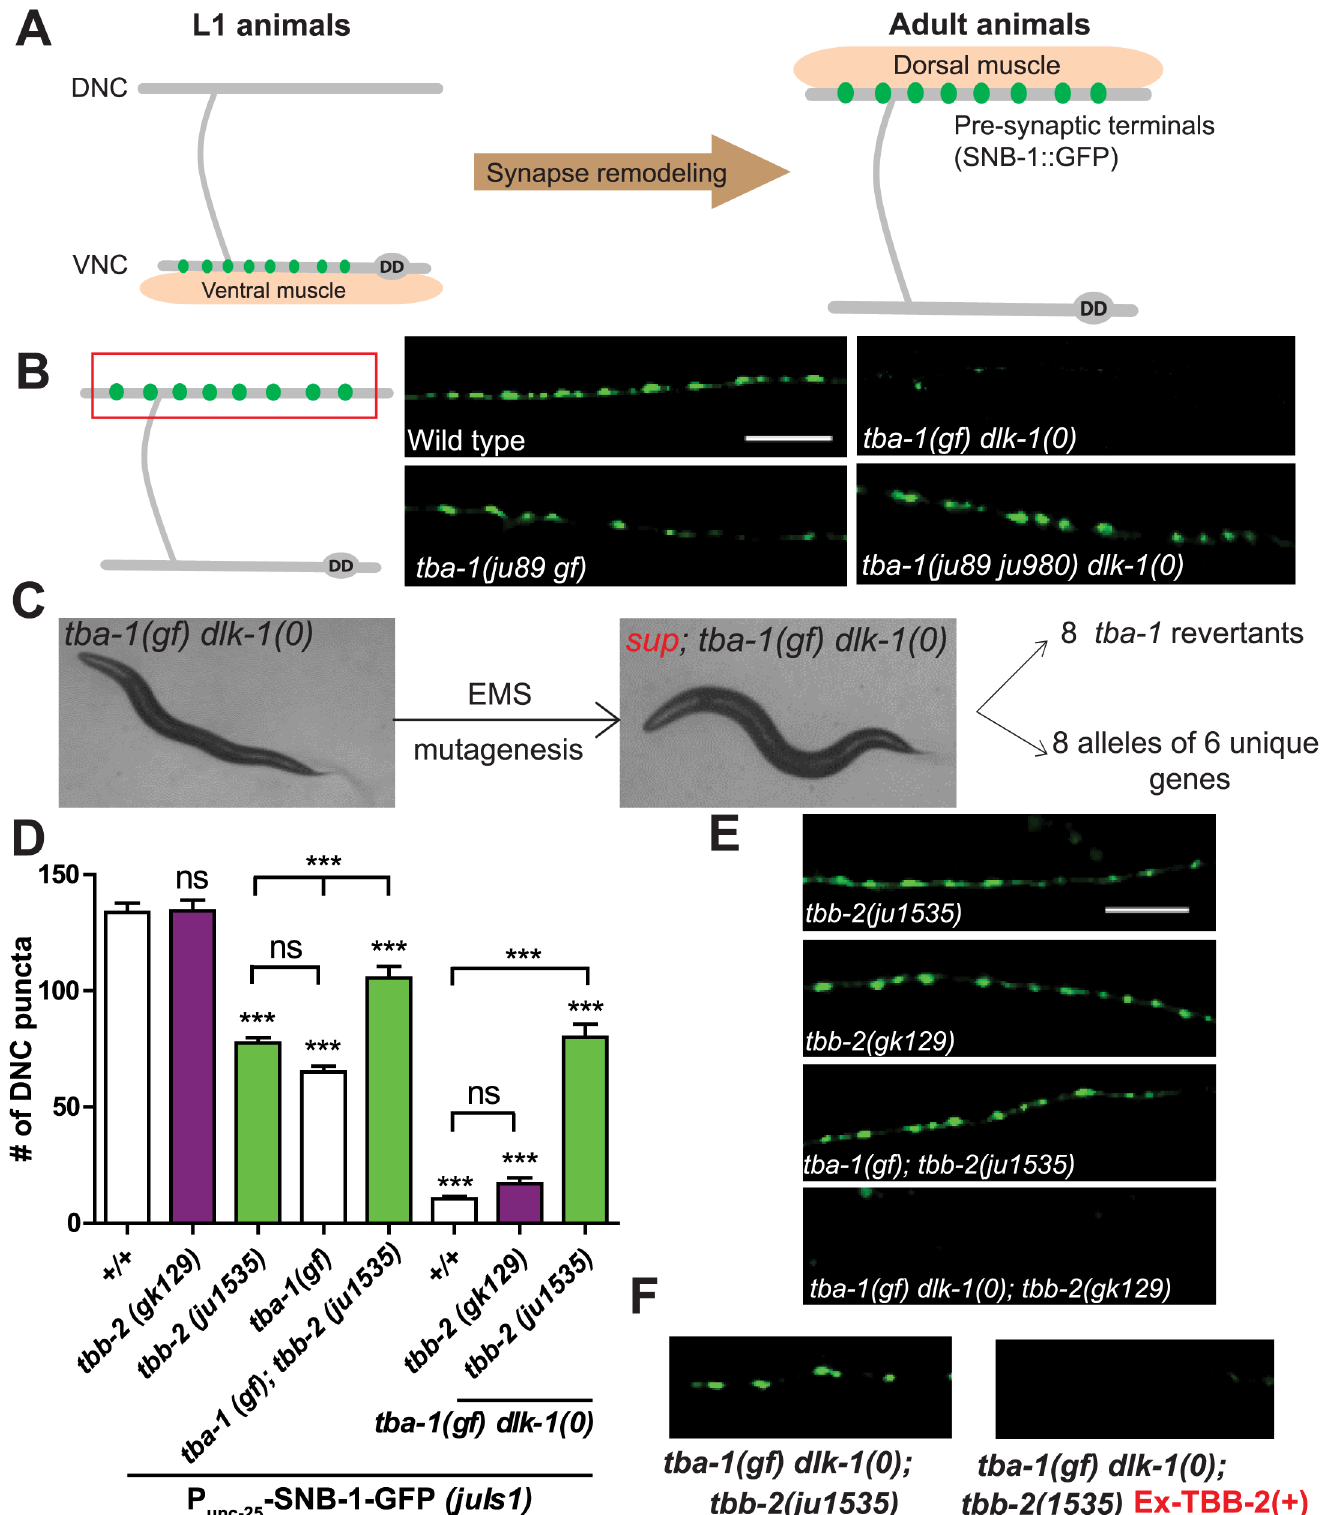
Fig 1. Intragenic mutations in tba-1 and a novel tbb-2 mutation suppress synapse remodeling defects in tba-1(gf) dlk-1(0) . (A) Schematic of remodelingof DD neuronsynapses. In younglarvae, pre-synaptic terminals are visualizedalong the ventral nerve cord (VNC) using GFP- tagged